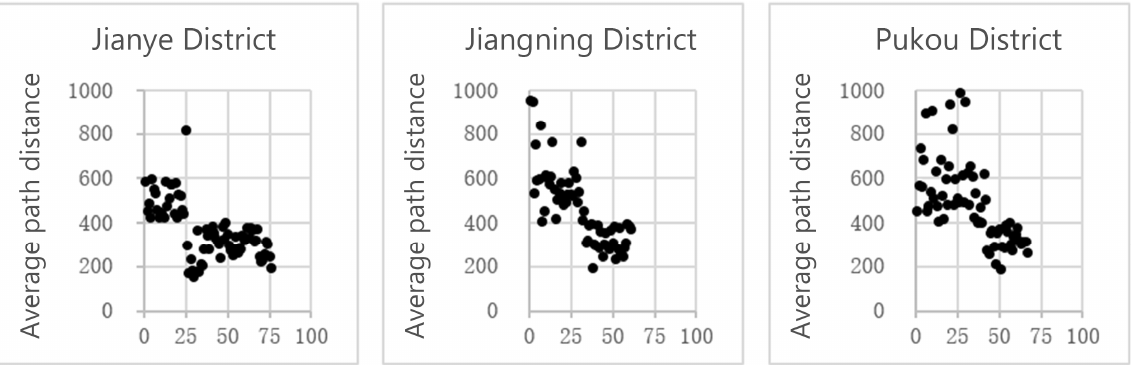
Figure 11. Average path distance of 204 residential areas in Jiangning, Jianye, and Pukou District. Table 7. Number and percentage of residential areas with different levels of path distance.